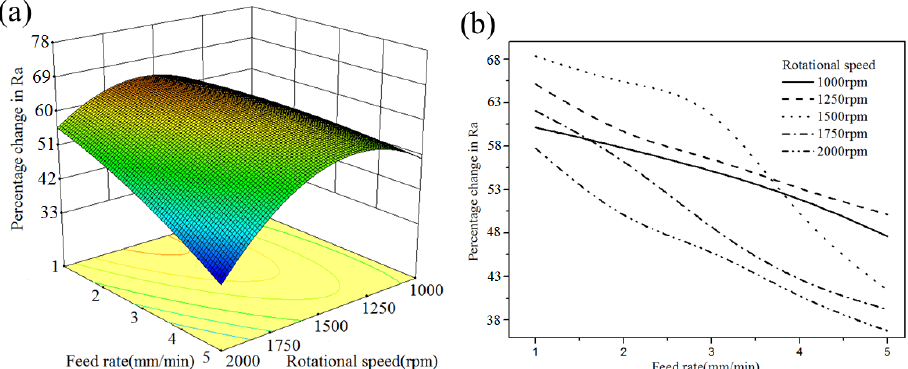
Figure 12. Interaction effect between the feed rate and rotational speed (working gap: 1 mm; mesh no.150): ( a ) 3D curved surface; ( b ) 2D graph.